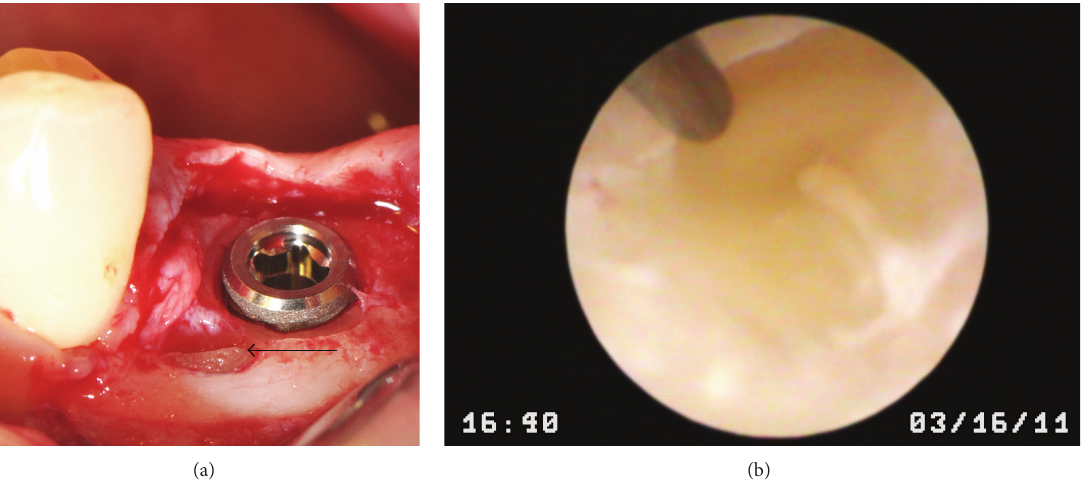
Figure 2: Removal by milling the coronal portion of the supernumerary tooth ankylosed to the vestibular cortex. Note the mesial and buccal relationship to the implant placed according to plan surgery. Black arrow shows the visualization of the supernumerary tooth crown near the buccal cortex after superficial osteotomy (a). Immersion endoscope (IE) visualization during the drilling of the radicular portion of the supernumerary tooth, observed with a yellowish color and apparently had two fused roots in an anterior portion